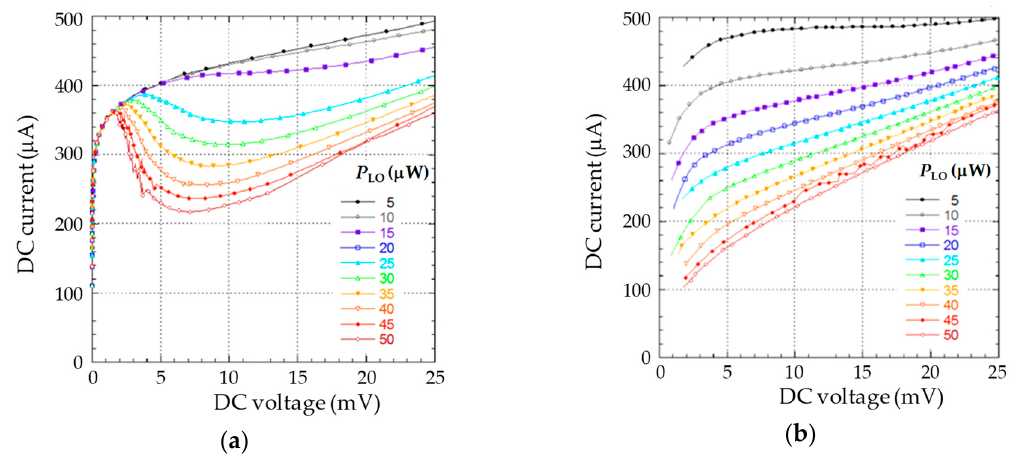
Figure 12. Comparing low-voltage behavior of DC I - V plots taking impedance matching factor with antenna into account: ( a ) Regular hot-spot model with uniform P LO power dissipation along the constriction; ( b ) our hot-spot model approach with I LO as an input parameter, i.e., non-uniform P LO power dissipation.